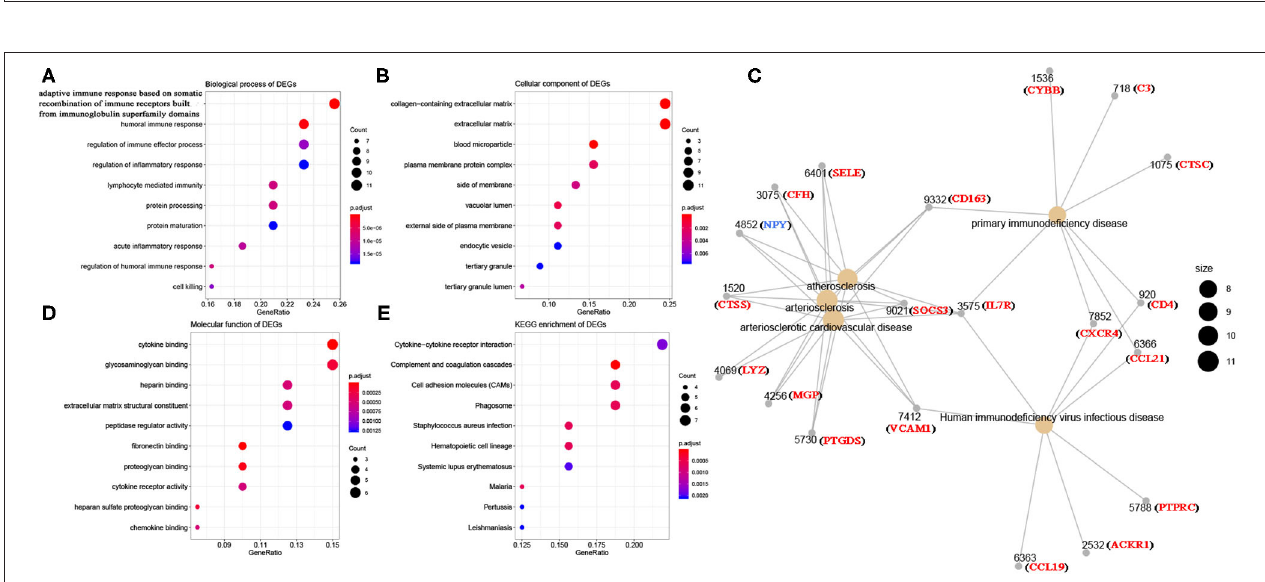
FIGURE 4 | Bioinformatics analysis of 45 DEGs associated with immune score and stromal score. (A) Biological process of DEGs. (B) Cellular component of DEGs. (C) Disease ontology of DEGs. (D) Molecular function of DEGs. (E) KEGG enrichment of DEGs.